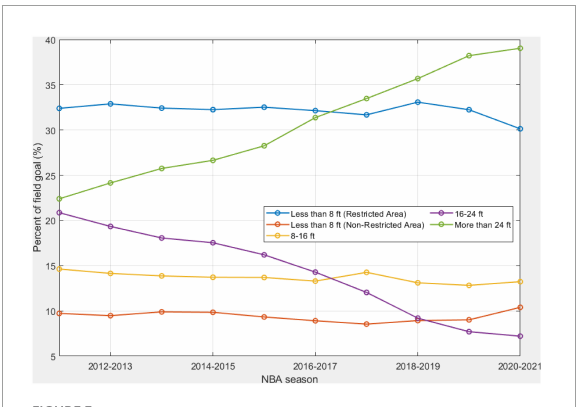
FIGURE3 Changes in the percentage of field goals from each of the five shooting distances in the past decade.